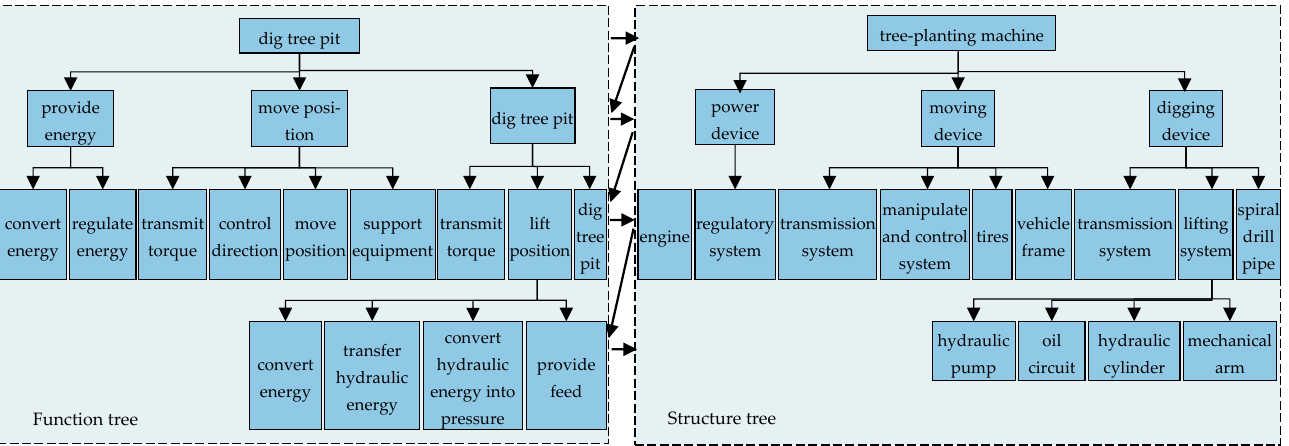
Figure 22. Function–structure mapping of the drill pole tree-planting machine. Figure 22. Function-structure mapping of the drill pole tree-planting machine. Figure 22. Function-structure mapping of the drill pole tree-planting machine.